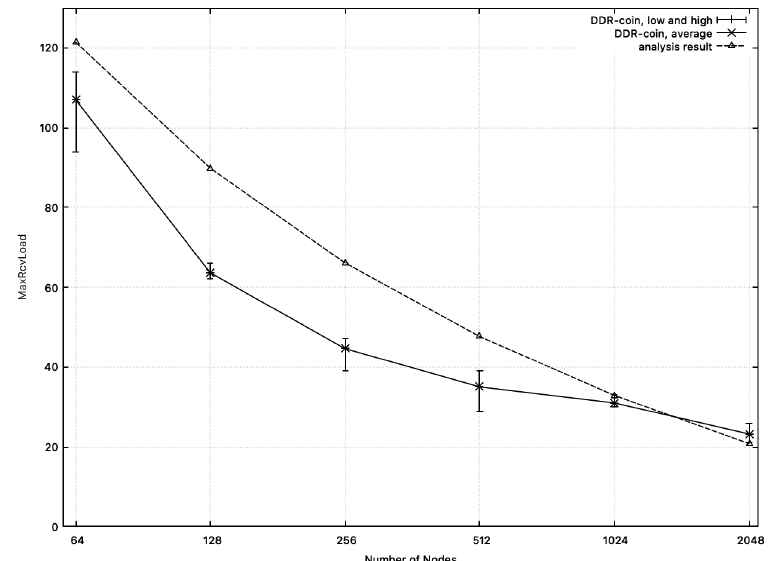
Figure 11. MaxRcvLoad: the measured numbers from simulations and the analysis results from Section 3 when n = 2 6 ∼ 2 11 , w = 10,000. The solid line represents MaxRcvLoad measured from simulation. The dotted line (analysis results) represents the function: 100 · log